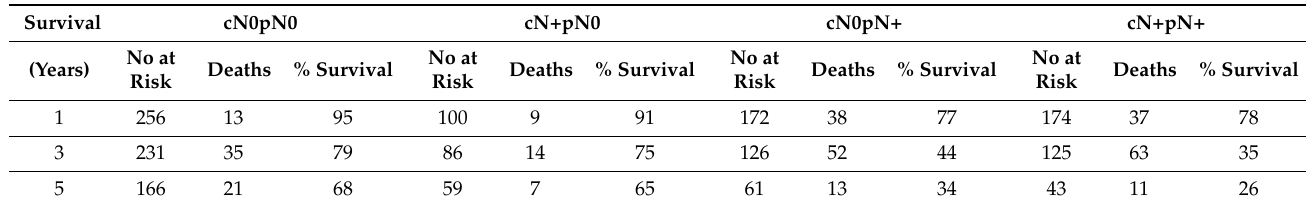
Table 4. Overall survival of OAC patients based on clinicopathological nodal status.